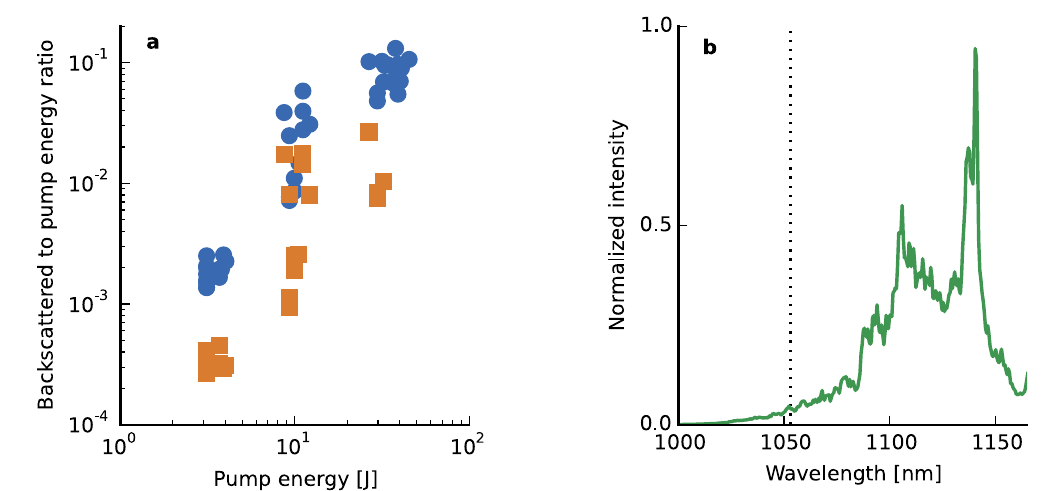
Figure 4. Measurements of backscattered energy. ( a ) Ratio of (blue circle) backscattered Raman and (orange square) elastic/Brillouin scattering energy to initial pump energy. Up to 10% of the pump energy is converted to SRBS. Elastic/Brillouin scattering accounts for one order of magnitude less. ( b ) Example of a corrected spectrum obtained for a pump energy of 38 J. An estimated backscattered energy of 5 J is